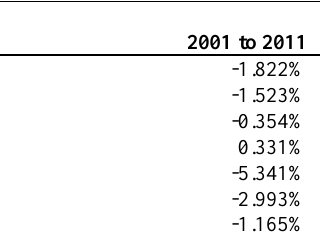
Table 2: Median growth in human capital efficiency from 2001 to 2011